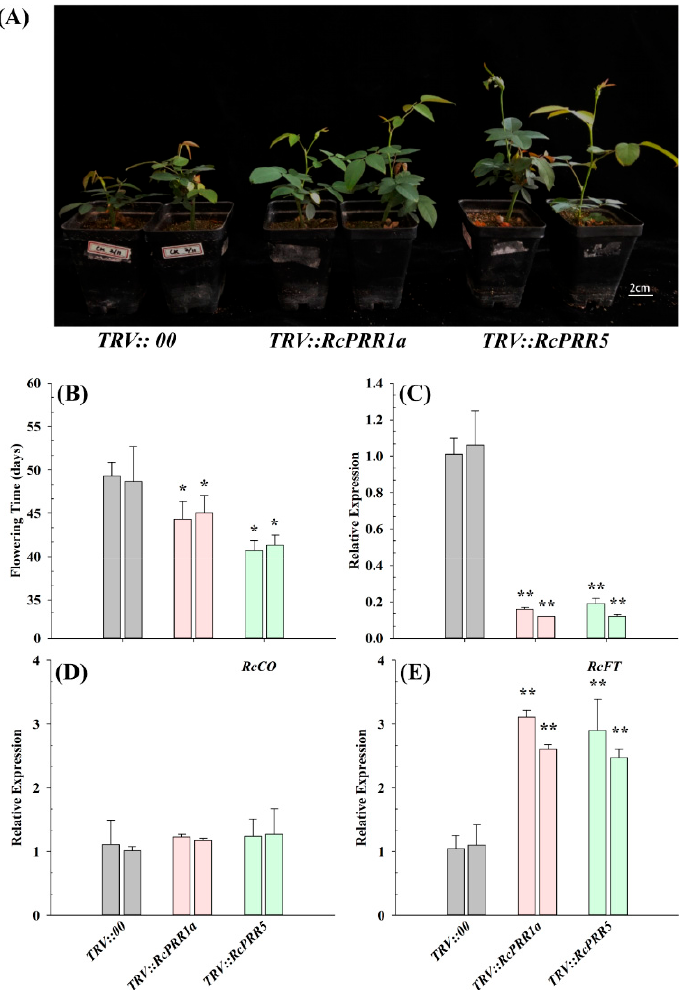
Figure 8. Silencing of RcPRR1a and RcPRR5 in Rosa chinensis . ( A ) Flowering phenotype; ( B ) flowering time (days) of Rosa chinensis ; and ( C ) expression levels of RcPRR1a and RcPRR5 in two independent gene silenced lines; ( D ) expression levels of RcCO in two independent gene silenced lines; ( E ) expression levels of RcFT in two independent gene silenced lines. Gray bars, pink bars, and light green bars indicated the two independent lines of control, silenced lines of RcPRR1a and silenced lines of RcPRR5, respectively. Rose GAPDH gene was used as a reference. Three biological replicates were performed for each experiment. Asterisks above the bars indicate significant differences between gene silenced lines and the control as determined by the LSD test, ** p < 0.01 and * p <